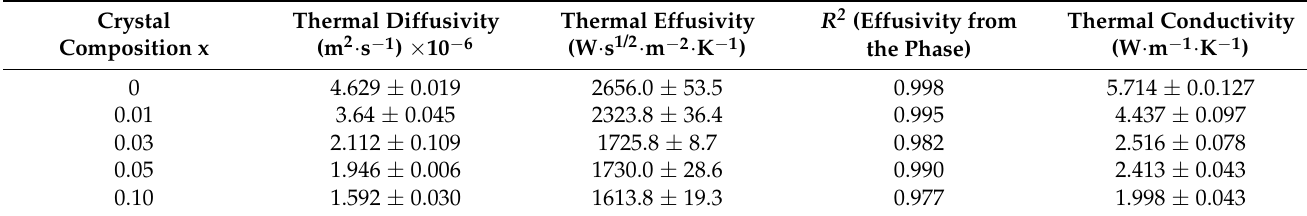
Table 1. Measured thermal parameters of Cd 1–x Be x Te crystals.